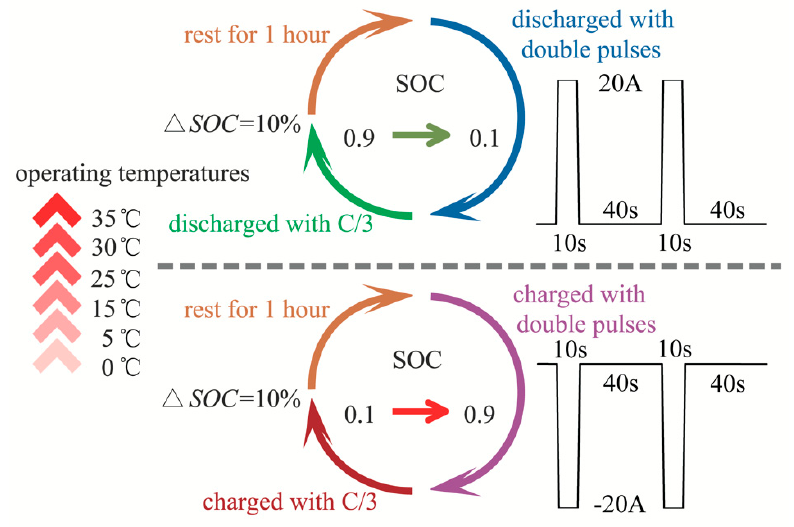
Figure 8. Scheme of parameter identification test using double pulses under charging–discharging states at different temperatures in the range 0–35 °C.